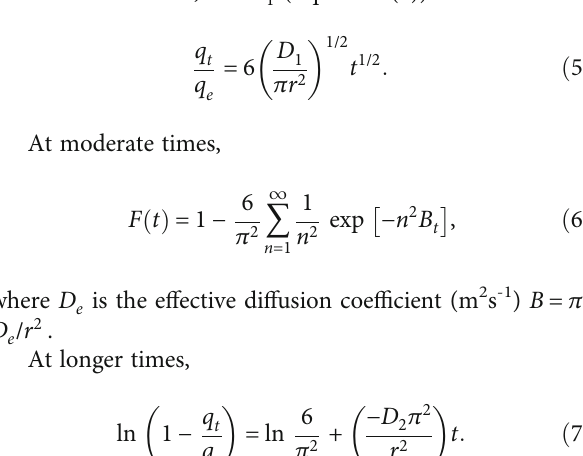
Table 1: Nature of biomass and their